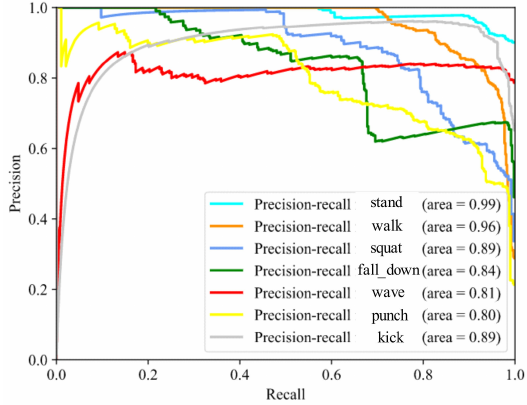
Figure 16. P-R curve of the